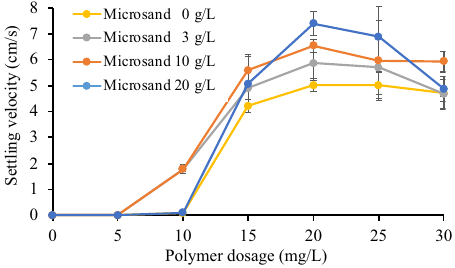
Fig. 6 Relationships between fl oc settling velocity and polymer fl occulant dosage in softening with ballasted fl occulation (SBF) with different micros and dosages ( n = 3, means ± standard deviations). Anionic polymer (AP825B) was used in